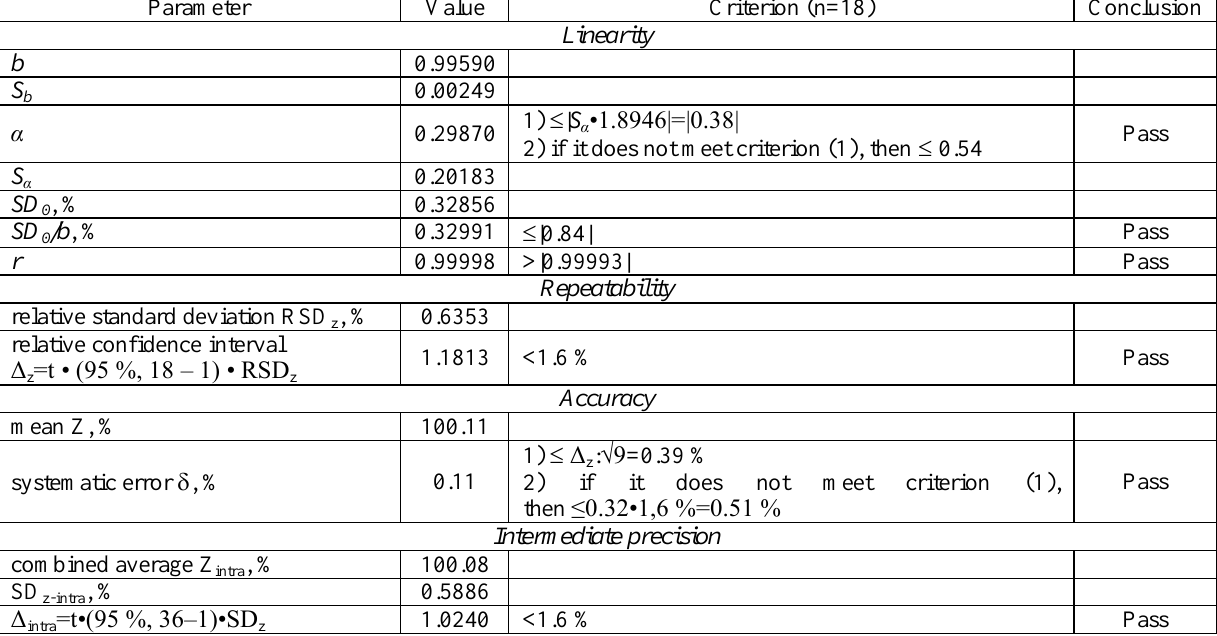
Fig. 4. Representative chromatograms obtained with placebo solution (1), reference solution (2), test solution Fig. 5. Chromatograms obtained with the model solution (3) when determination of the fine particle dose of BD of BD 0.5 μg/ml, the peak with Rt=7.059 min was performed (peaks with Rt=7.395 min and corresponds to BD (S/N=30.81) Rt=7.402 min correspond to BD) The results of the study in regard to validation characteristics of the analytical procedure for the quantitative determina- tion of beclometasone dipropionate (BD) and their evaluation against the acceptance criteria [6] Parameter